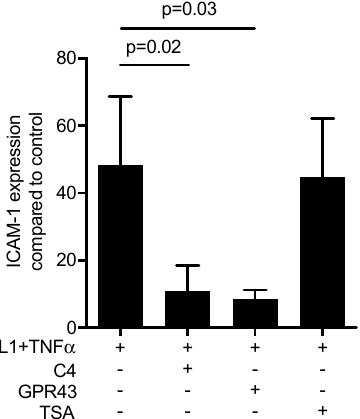
Figure 4. Activation of free fatty acid receptor-2 (FFAR2/GPR43) can mimic the activity of 10 mM of butyrate (C4) on ICAM-1 in HSC-2 cells. HSC-2 cells were exposed to a FFAR2/GPR43 agonist at 30 µM and trichostatin A (TSA) at 10 nM, respectively, for 24 h before ICAM-1 was induced. (+), indicates presence; (-), indicates absence. Data represent the mean change of ICAM-1 expression ± standard deviation. n = 3. Statistical analysis was based on Mann–Whitney U test and t-test, p -values are indicated.